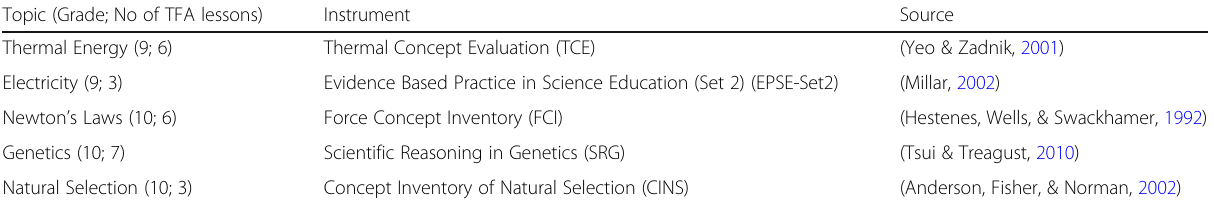
Table 1 Topics taught and instruments used to measure conceptual change Topic (Grade; No of TFA